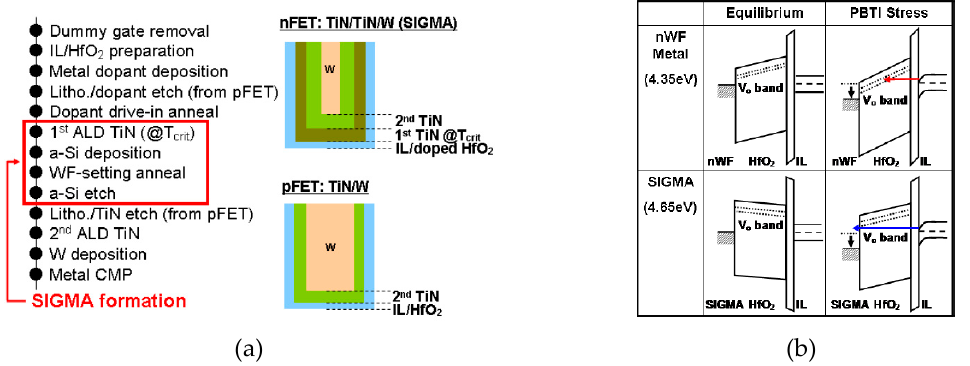
Figure 27. ( a ) CMOS flow and schematics for NFET with SIGMA / W stack and PFET with TiN / W stack and ( b ) PBTI improvement mechanism for the SIGMA stack [174].